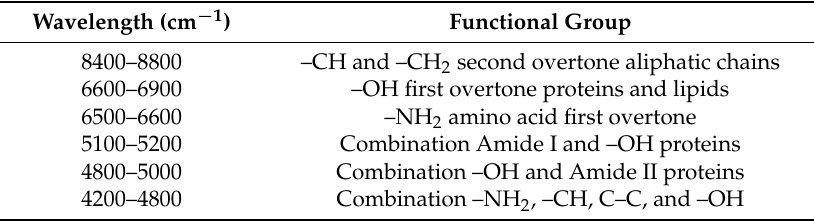
Table 2. List of the most significant FTNIR bands and related functional groups assigned for the Vicia faba samples.